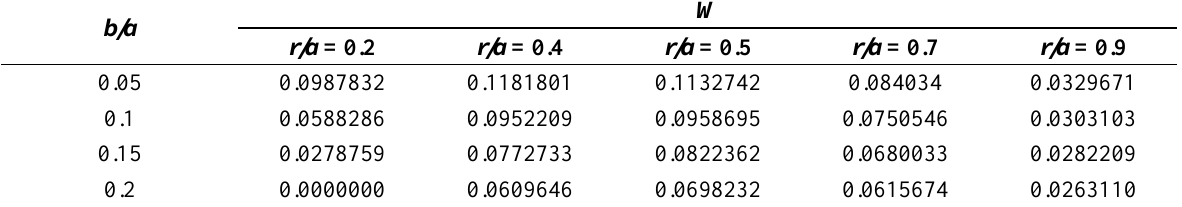
Table 5. Bending Moment at Several Points of the Plate with Ratio b/a Ranging from 0.05 to 0.2.